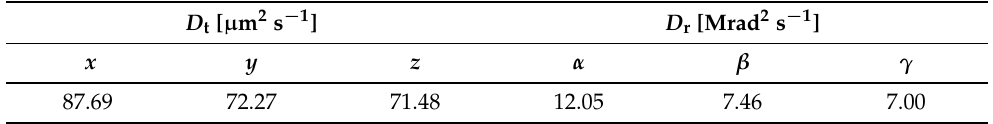
Table 2. Anisotropic translational ( D t ) and rotational ( D r ) diffusion coefficients for HBcAg 2 at 293 K and 150 mM NaCl used for MDEM (marked in light orange in Figure